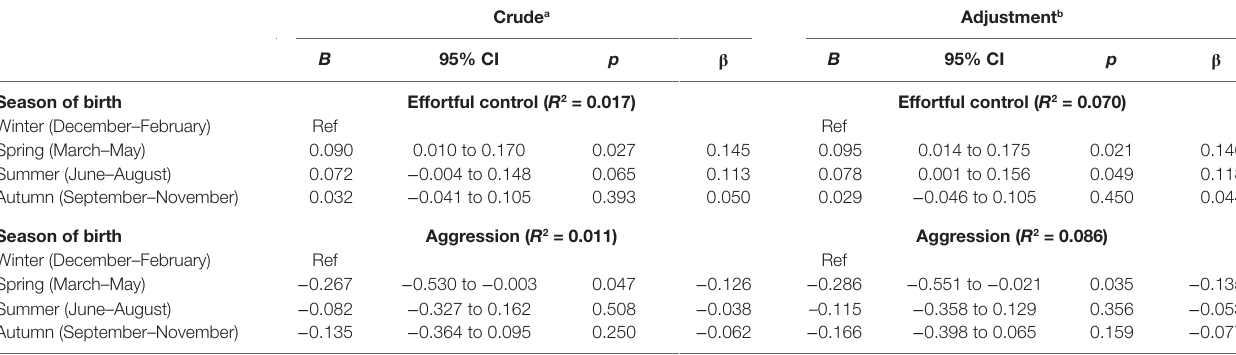
TaBle 3 | Predicting latent factors of effortful control and aggression by season of birth ( N =